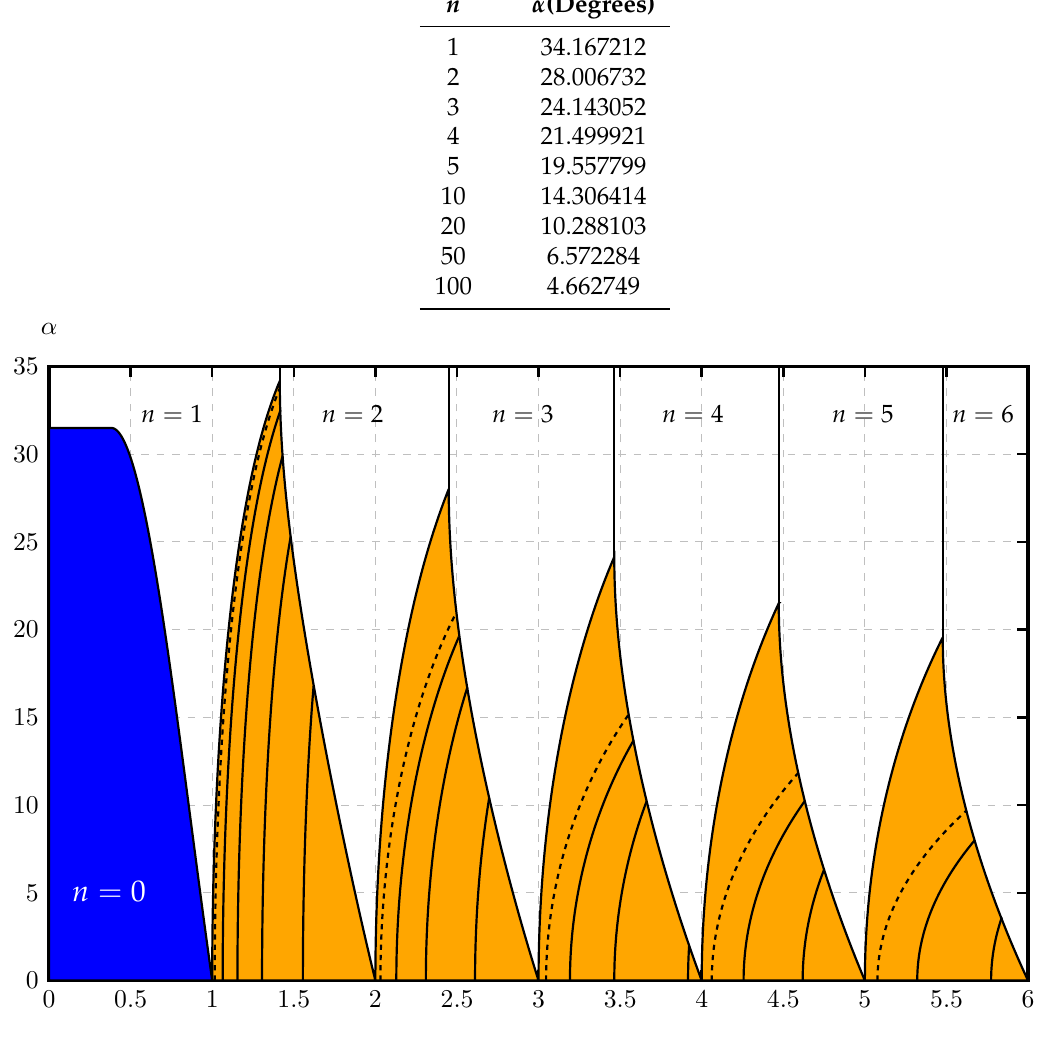
Figure 8. Modal map showing the form of the most dangerous disturbance. Blue signifies transverse rolls, orange signifies oblique rolls and white corresponds to longitudinal rolls. The vertical lines shows the boundary between longitudinal rolls with n cells and with n + 1 cells. The lines within each orange region denote the following values of φ : 10 ◦ (dashed), 20 ◦ , 30 ◦ , 40 ◦ and 50 ◦